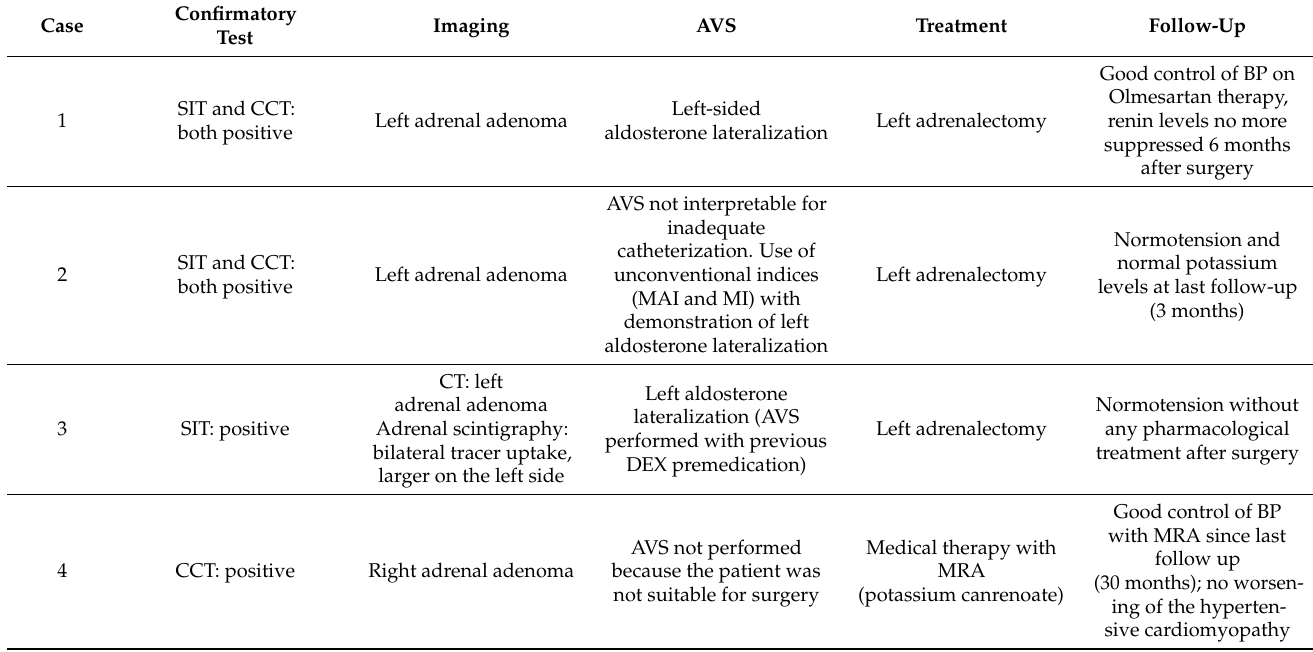
Figure 1. The balance of the diagnostic–therapeutic process in patients with PA. In our opinion, the choice between the two treatments (surgery or medical therapy with mineralocorticoid receptor antagonist, MRA) should be guided by clinical questions (summarized in the light blue box) matched with the process of the subtype of PA (using the imaging techniques depicted in the first part of the figure). Created with BioRender.com, accessed on 7 November 2022.